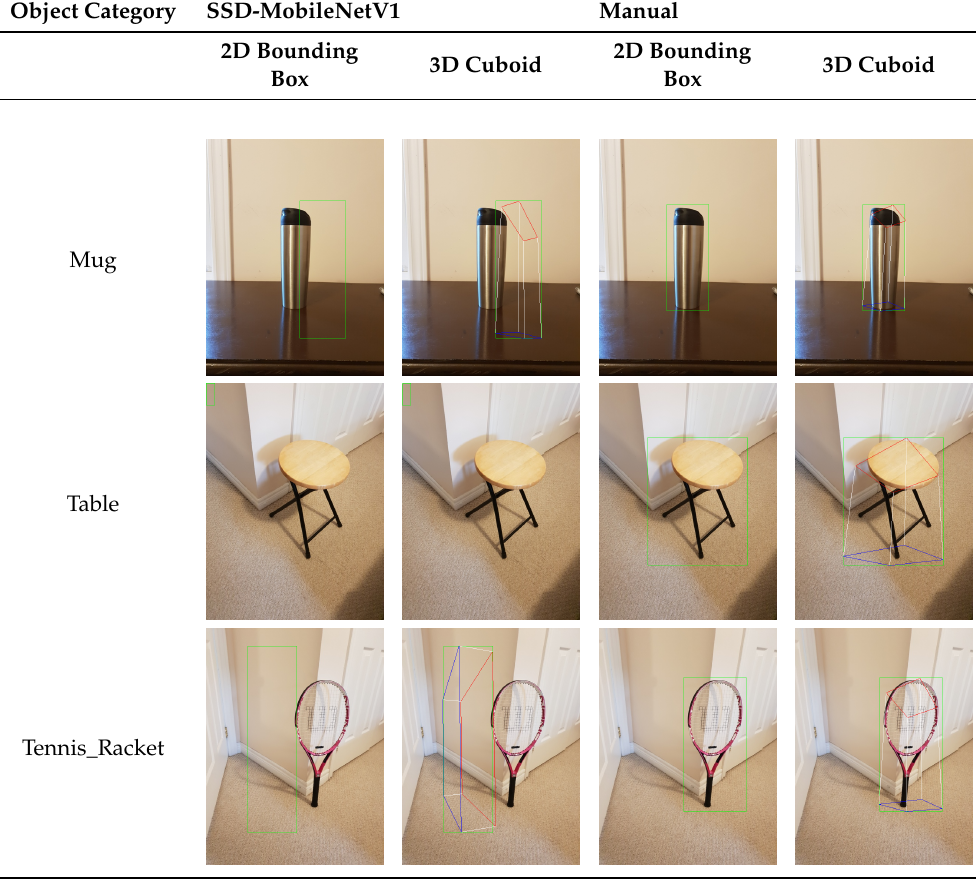
Table 3. 3D cuboid generated when 2D bounding box coordinates are obtained using SSD- MobileNetV1 and when defined manually. Note that in the case of object category Table , there is no object detected by SSD-MobileNetV1 and hence 3D cuboid is not